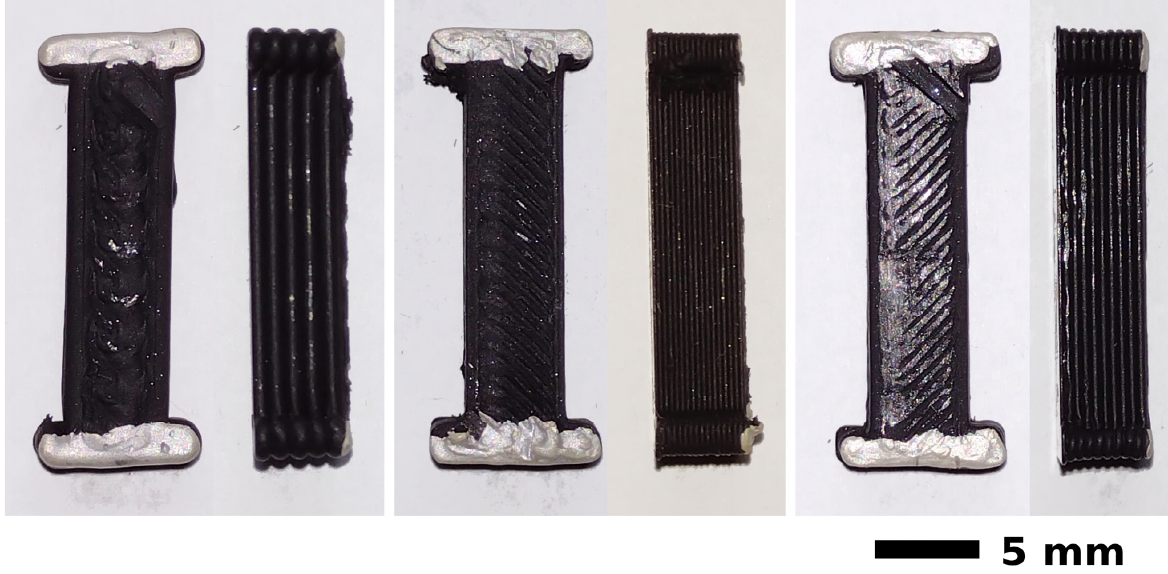
Figure 3. Representative samples of printed conductive beams (from left): 1 mm nozzle and 1 mm layer height; 0.5 mm nozzle and 0.3 mm layer height; 0.6 mm nozzle and 0.5 mm layer height.